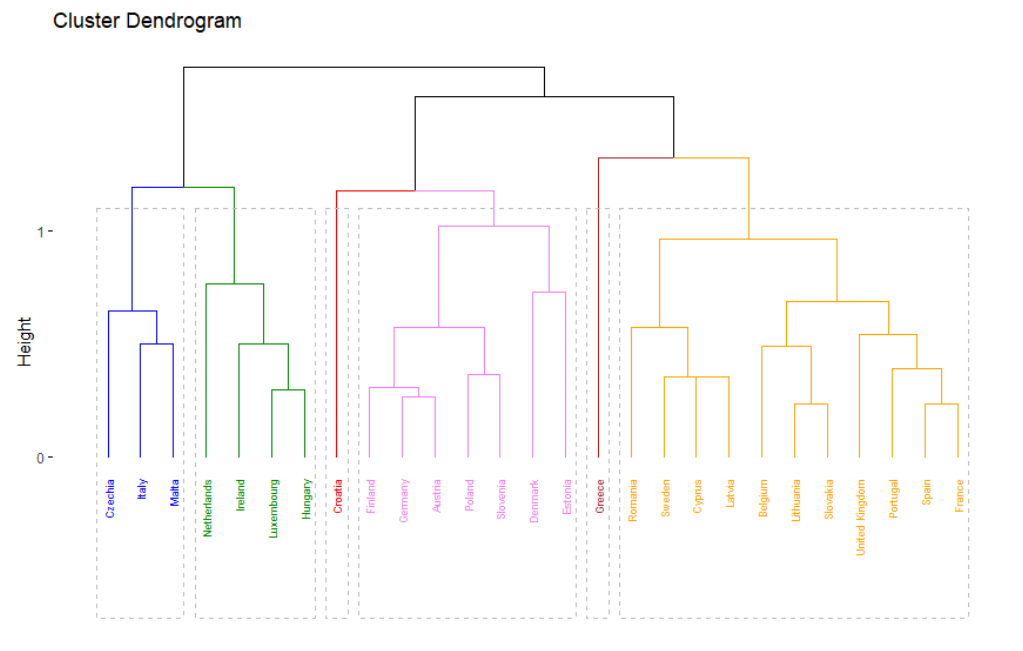
Figure 6. Dendrogram for the years 2011-2017. Source: author’s own study carried out using the ‘factoextra’ package in R environment (Kassambara and Mundt,